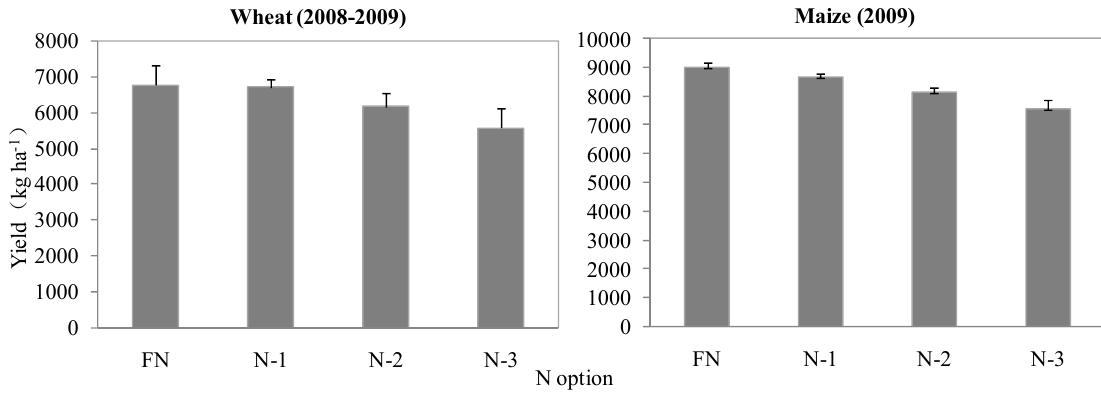
Figure 2. The yield of wheat and maize under different N options.